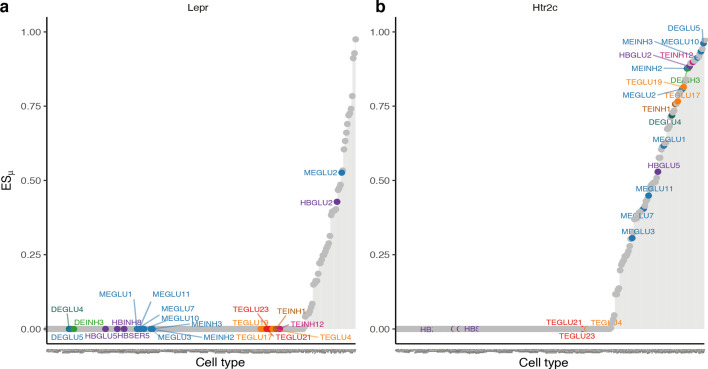
Expression specificity of the leptin- and serotonin receptors across BMI GWAS enriched cell types.(a) In the lipostatic model of obesity originally defined by Kennedy, 1953, circulating concentrations of the leptin hormone signal the amount of energy stored in fat cells to the brain. The plot shows gene ESμ (y-axis) for each cell type (x-axis, ordered by increasing values of expression specificity, ESμ) with BMI-prioritized cell types from the Mouse Nervous System dataset highlighted. In our analysis, only two of the 22 BMI GWAS enriched cell types specifically expressed the leptin receptor (MEGLU2, periaqueductal grey; and HBGLU2, nucleus of the solitary tract). (b) Seventeen of the 22 BMI GWAS enriched cell types specifically expressed the serotonin (5-htr2c) receptor. The strongest enrichment was observed for DEGLU5, a glutamatergic cell type from the anterior pretectal nucleus. ESμ, expression specificity.